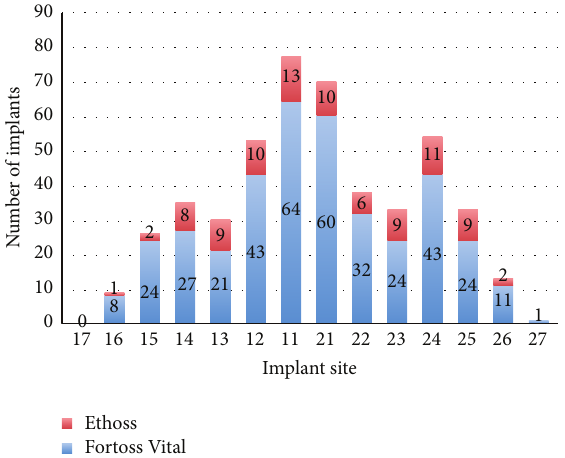
Figure 1: Implant distribution and grafting material used in maxilla.